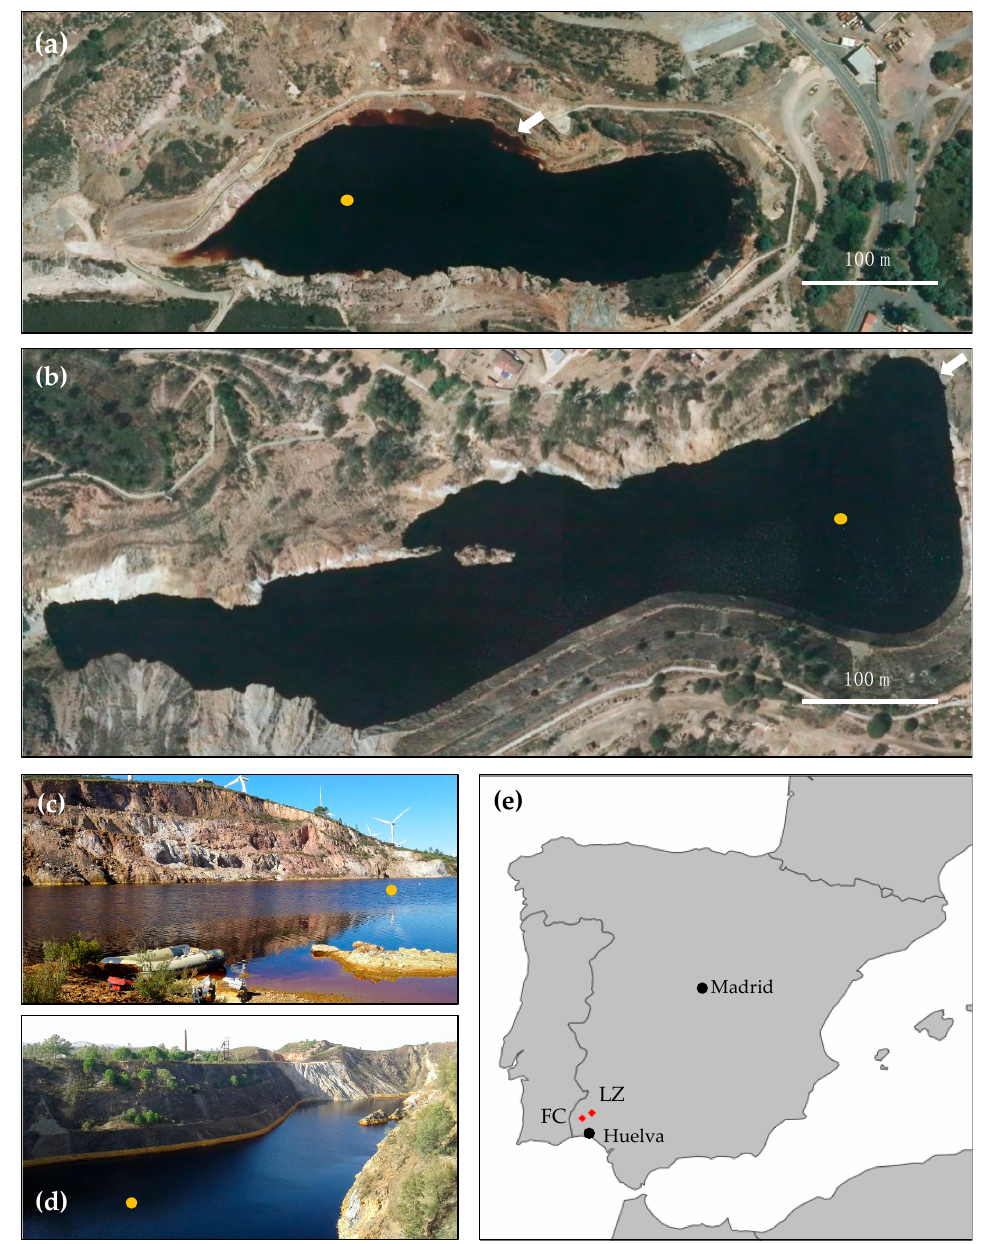
Figure 1. The acidic pit lakes Filón Centro (FC, Tharsis) ( a , c ) and La Zarza (LZ) at the La Zarza Perrunal mine ( b , d ); ( e ) the two pit lakes are located in Huelva province, southwest Spain. The orange dot indicates the sampling location. The white scalebar indicates 100 m. The arrows in ( a , b ) indicate the location and direction from which pictures ( c , d ) were taken, respectively.